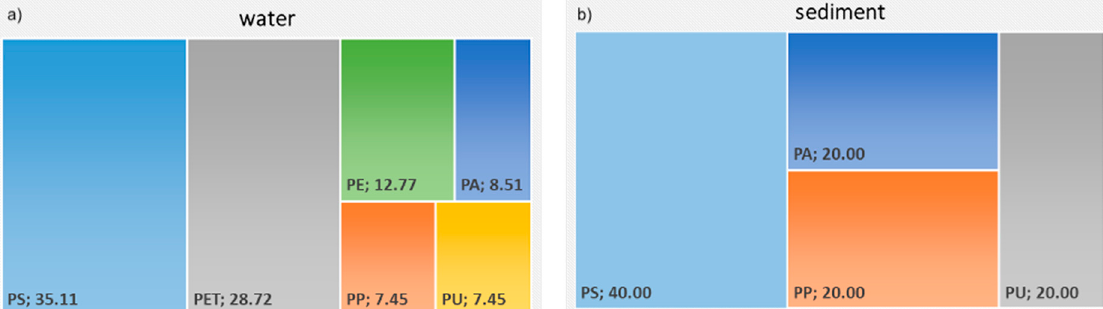
Figure 2. Chemical composition of microplastics (in percentage of abundance) detected in water ( a ) and sediment ( b ) samples ( n = 3) from the Vipacco River. PA denotes polyamide; PP polypropylene; PET polyethylene terephthalate, PU polyurethane; PS polystyrene; PE polyethylene.